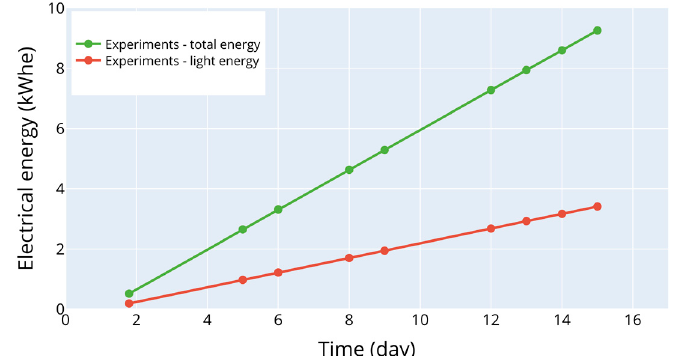
Figure 4. Total process consumed electrical energy and light consumed electrical energy over time. Measurements started after 24 h. Fitted values: total energy (kWhe) = 0.662 × time (day) ± 0.000. R 2 = 1. Lighting energy (kWhe) = 0.244 × time (day) ± 0.000. R 2 = 1.